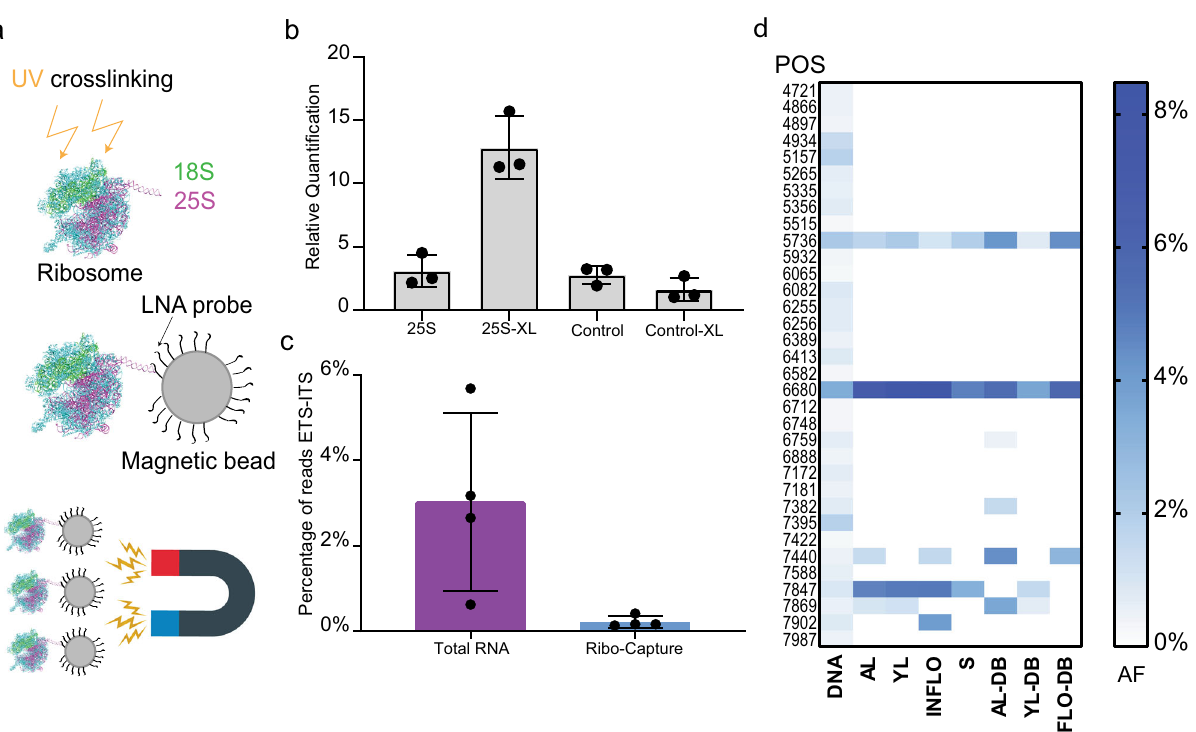
Fig. 5 rRNA variants are differentially expressed between tissues. a Ribosome capture strategy for enriching mature ribosomes. Ribosomes are UV- crosslinked and captured with a magnetic bead coupled to a DNA/LNA mixamer with high af fi nity for the 25 S rRNA. b Graph depicting the relative quanti fi cation of 25S rRNA by qPCR after ribosome capture. Non-crosslinked ribosomes captured with the 25S LNA (25S), crosslinked ribosomes captured with the 25S probe (25S-XL), non-crosslinked ribosomes captured with an LNA probe that does not bind to the ribosome (Control), and crosslinked ribosomes captured with an LNA probe that does not bind to the ribosome (Control-XL). c Graph depicting the percentage of Illumina reads mapping to the ETS-ITS regions of the rDNA relative to the total amount of reads that map to the entire rDNA unit from total RNA and ribo-capture experiments. The reads from all tissues analyzed were used for this analysis. The ETS-ITS regions of the rDNA are present in the pre-rRNA but not present in mature ribosomes. d Heat map representing the allele frequency of SNPs found in the 25S of mature ribosomes in different tissue types. Blue boxes represent the highest value (8%), white boxes represent the lowest value (0%). The y -axis represents the positions of the SNPs with respect to the reference rDNA and are as follows: from top to bottom 4721, 4866, 4897, 4934, 5157, 5265, 5335, 5356, 5515, 5736, 5932, 6065, 6082, 6255, 6256, 6389, 6413, 6582, 6680, 6712, 6748, 6759, 6888, 7172, 7181, 7382, 7395, 7422, 7440, 7588, 7847, 7869, 7902, and 7987. The x -axis de fi nes the different tissue types and sources: adult leaves (ALs), young leaves (YLs), in fl orescences (INFLOs), siliques (S), online repository derived reads (DB), DNA (whole-genome sequencing data